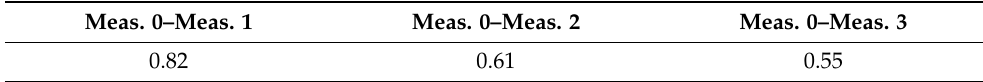
Table 6. Helmert transformation errors (mm).